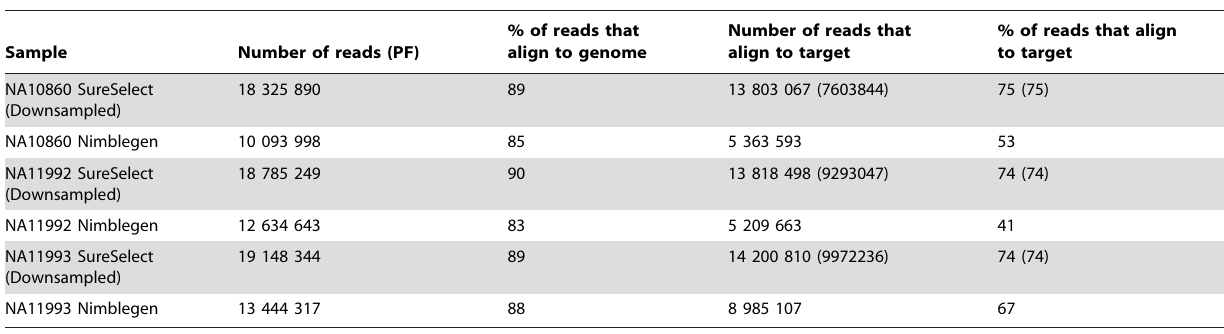
Table 1. Sequencing and alignment statistics.